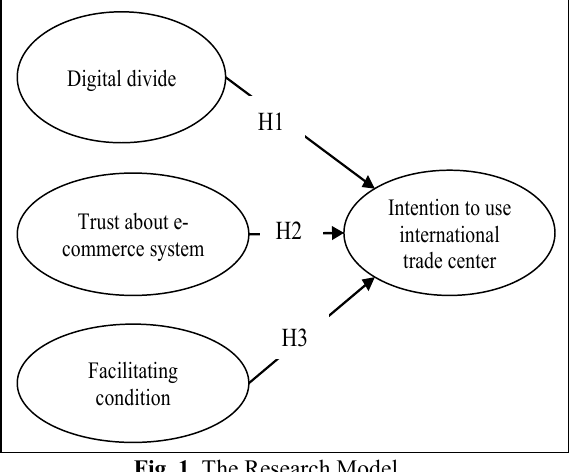
Fig. 1. The Research Model